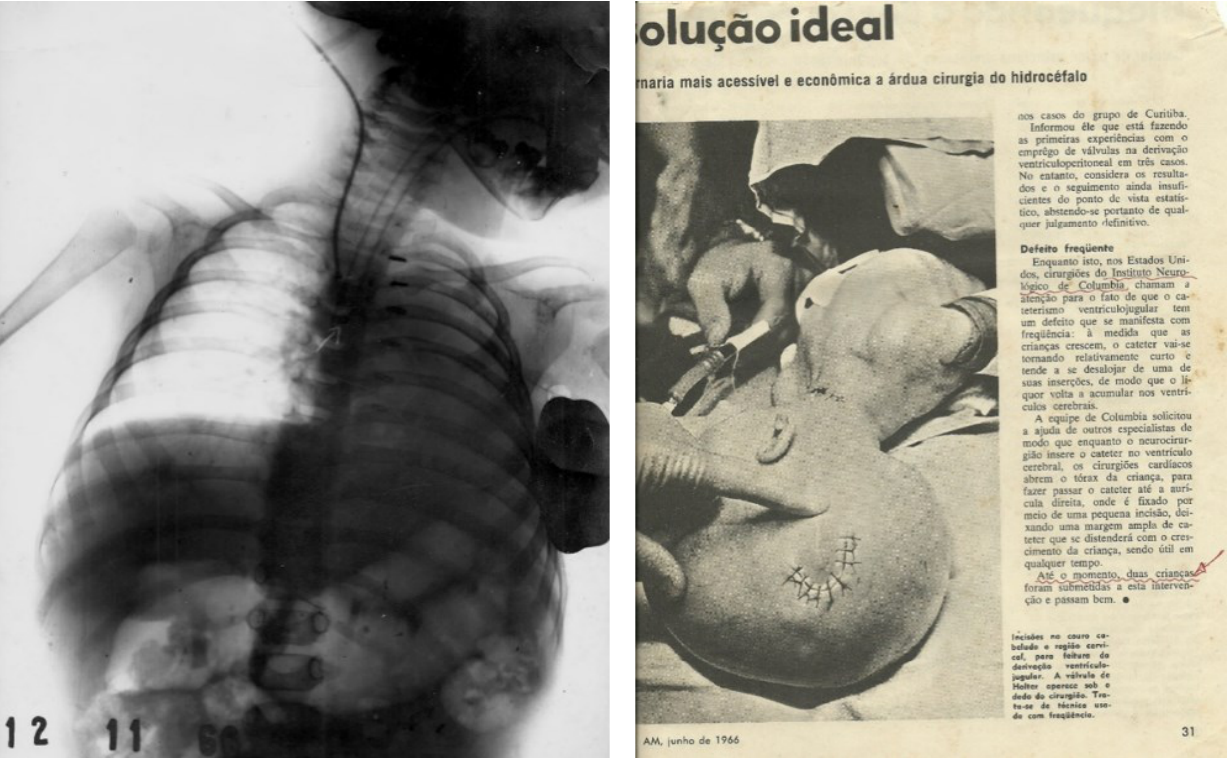
Figure 5 - Postoperative chest X-ray, with positioning of the distal catheter at the entrance to the right atrium.